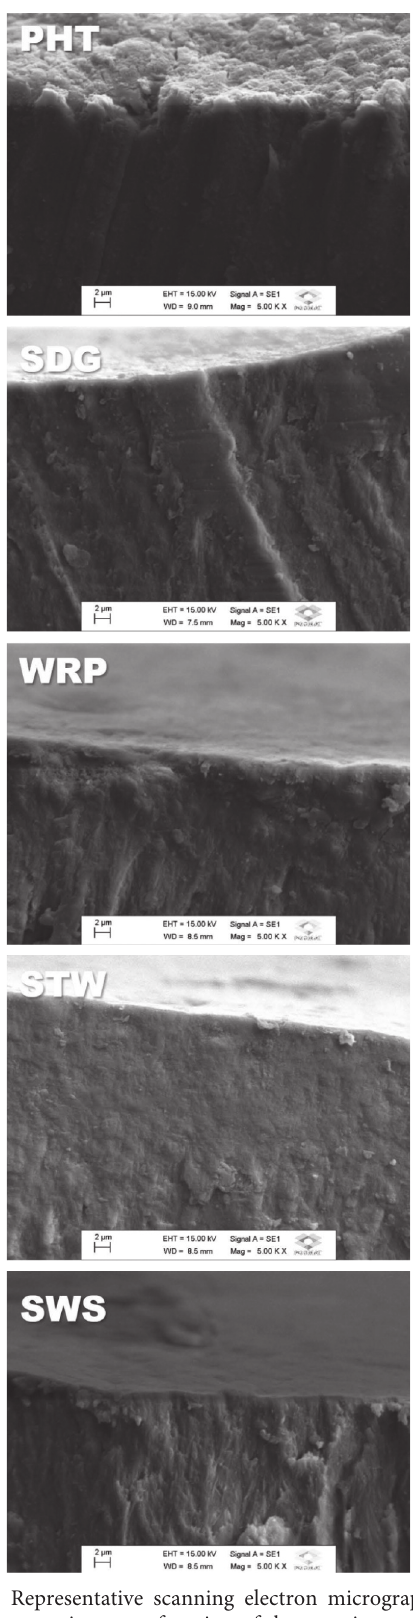
Figure 2: Representative scanning electron micrographs of the enamel cross-sections as a function of the experimental group.